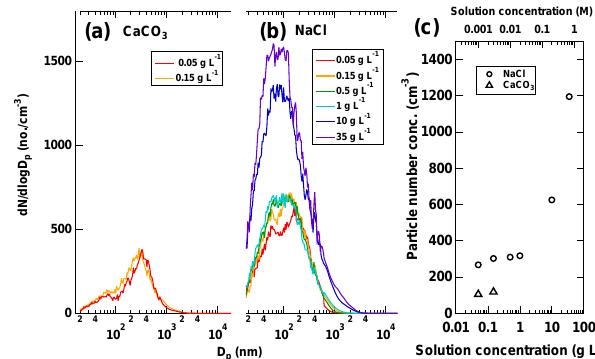
Figure 7. Bubble size distributions (density vs. bubble radius) gen- erated by the LSA generator as a function of solution concentration for (a) CaCO 3 and (b) NaCl, as well as (c) total bubble density as a function of ion composition for CaCO 3 and NaCl.